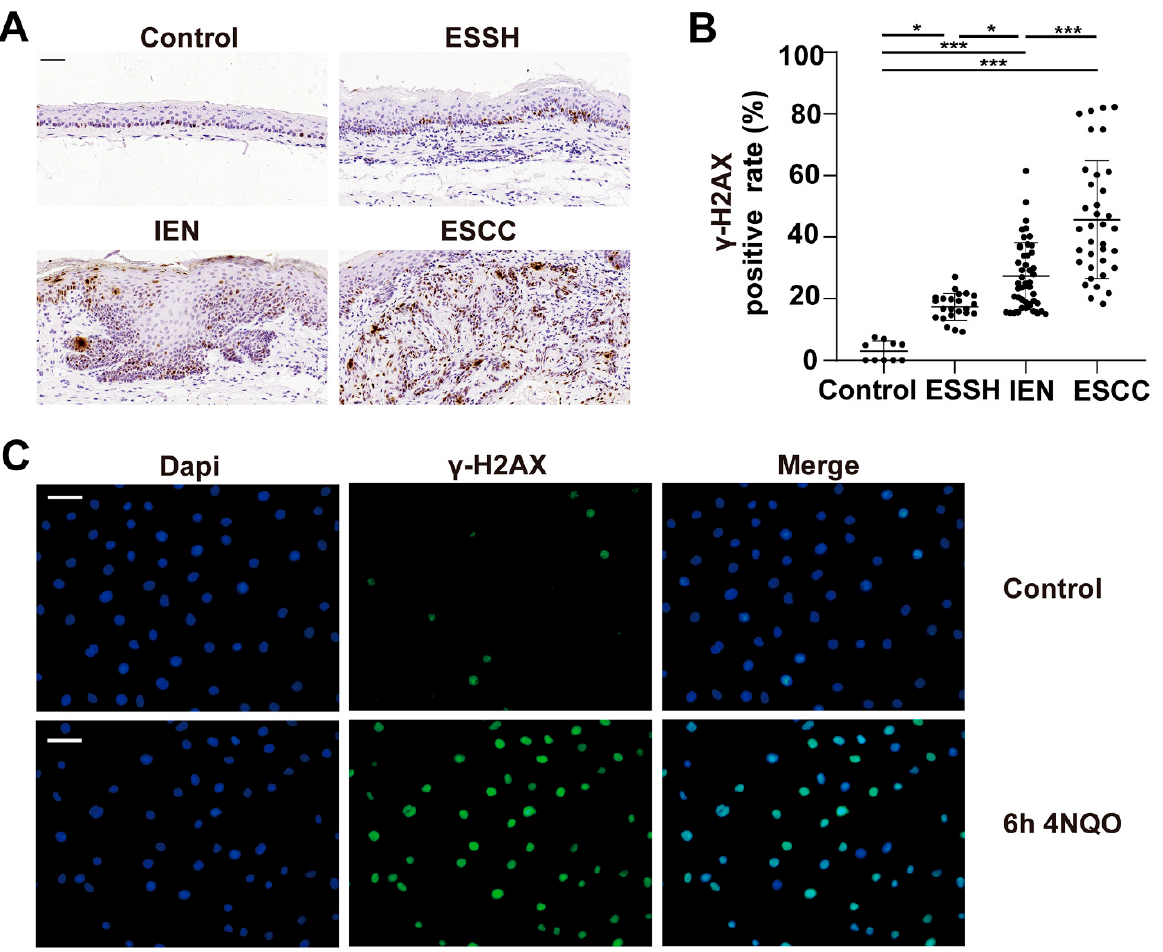
Figure 2. 4NQO treatment enhances DNA damage in the esophagus of mice and the NE2 cell line. The mice were sacrificed, and the esophagus sections were fixed, embedded in paraffin, and sectioned. Then, the tissue sections were stained with γ -H2AX antibodies. Four to five representative areas of each esophagus section from each mouse per group were photographed and analyzed. ( A ) Immunohistochemical staining of γ -H2AX for each stage. ( B ) Statistical analysis of γ -H2AX positive cells for each stage. Differences are significant at * p < 0.05 ESSH, IEN vs control; *** p < 0.0001 ESCC vs. control, ESSH, IEN. The difference with p ≤ 0.05 was considered statistically significant. Magnification, ×400; scale bar = 50 μ m. NE2 cell line treated with 4NQO for 6 h. γ -H2AX expression was